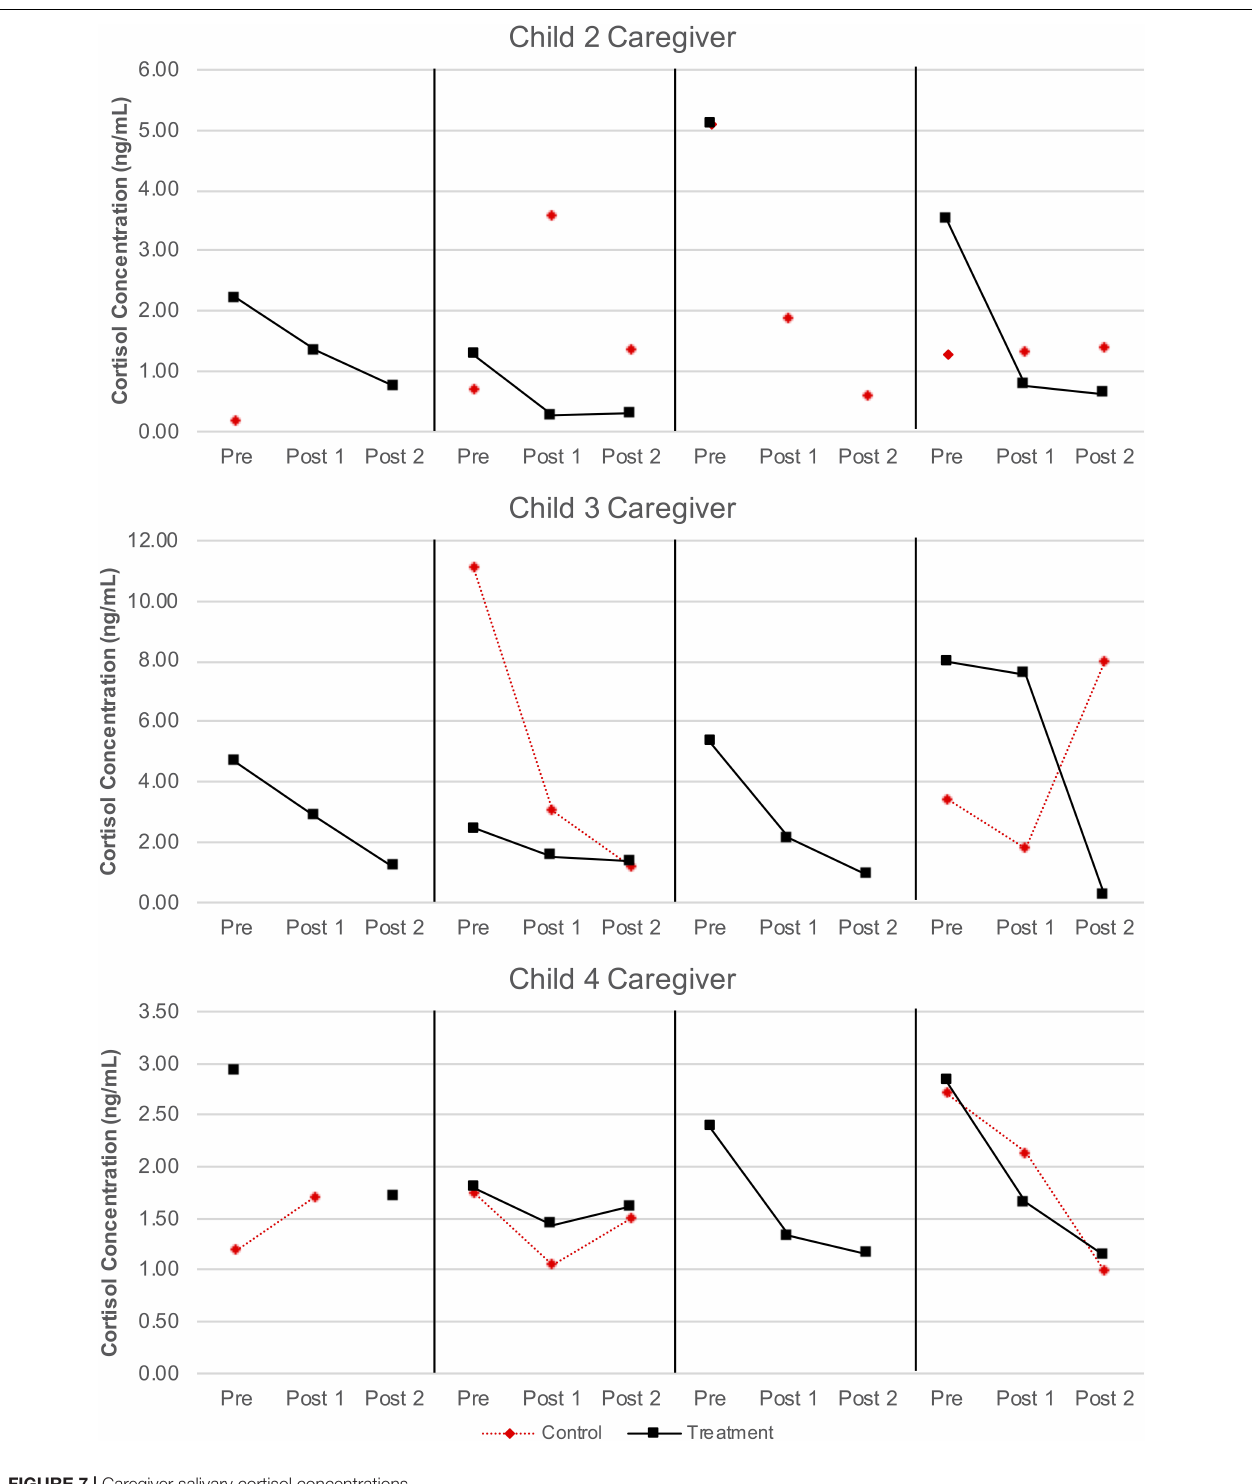
levels of blood cortisol concentrations on treatment and control condition days, though this must be interpreted with caution due to the schedule of the SCD. It is possible that on control